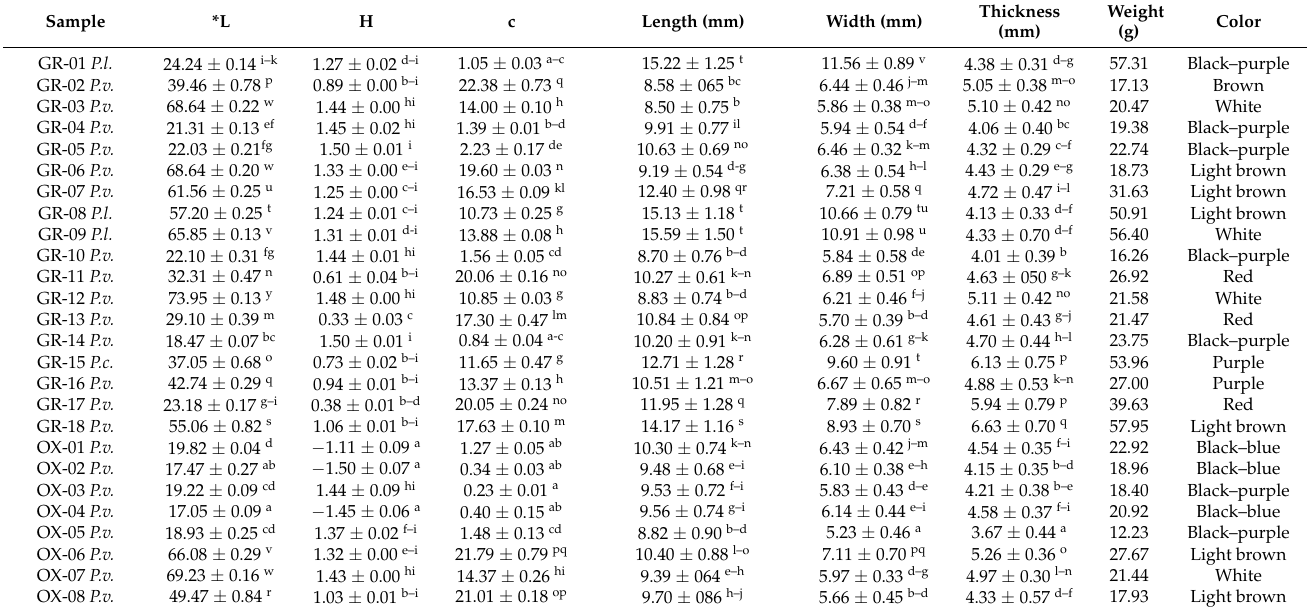
Table 1. Physical characteristics of bean seeds ( Phaseolus spp.) collected in the states of Guerrero and Oaxaca, Mexico. Sample